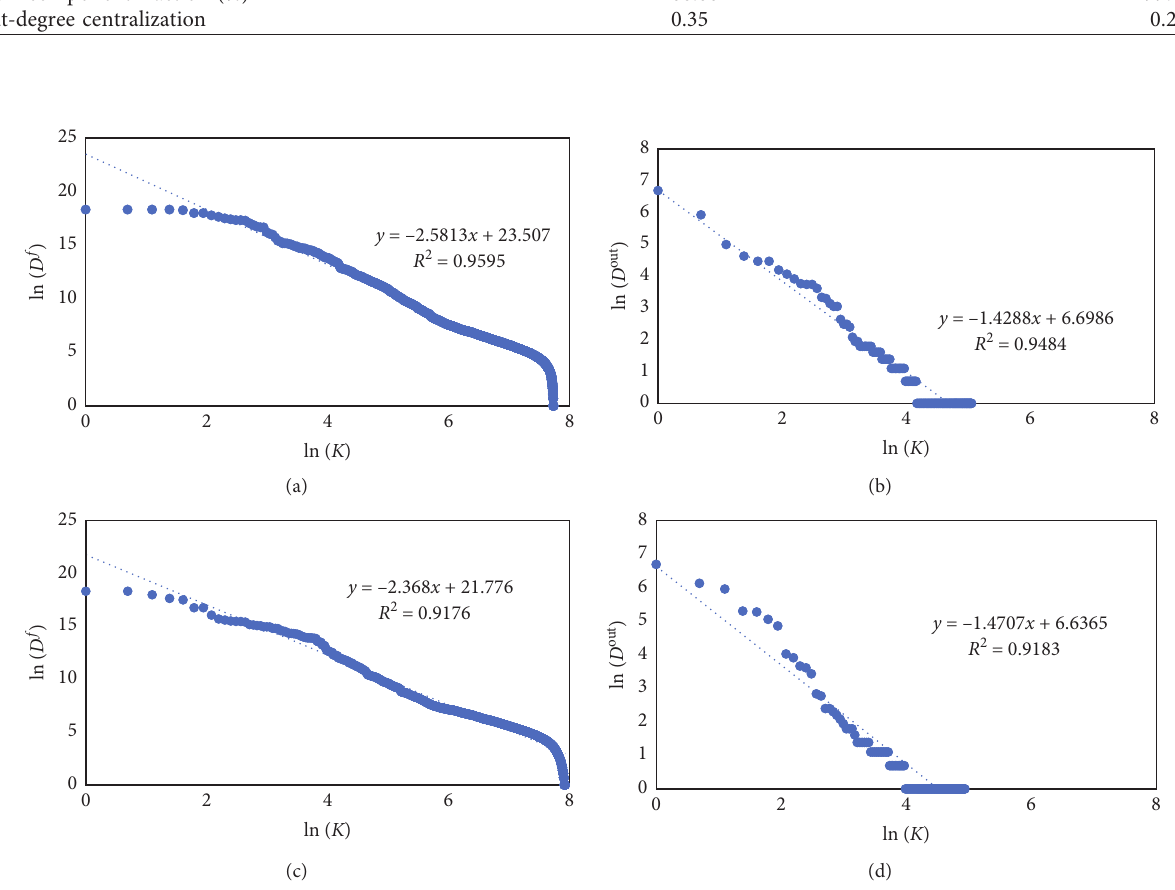
Figure 5: The distribution patterns in log-log graphs: (a) the number of followers ( D f ) and (b) the number of messages forwarded (out- degree ( D out )) in GCPN, (c) the number of followers ( D f ), and (d) the number of messages forwarded (out-degree ( D out )) in